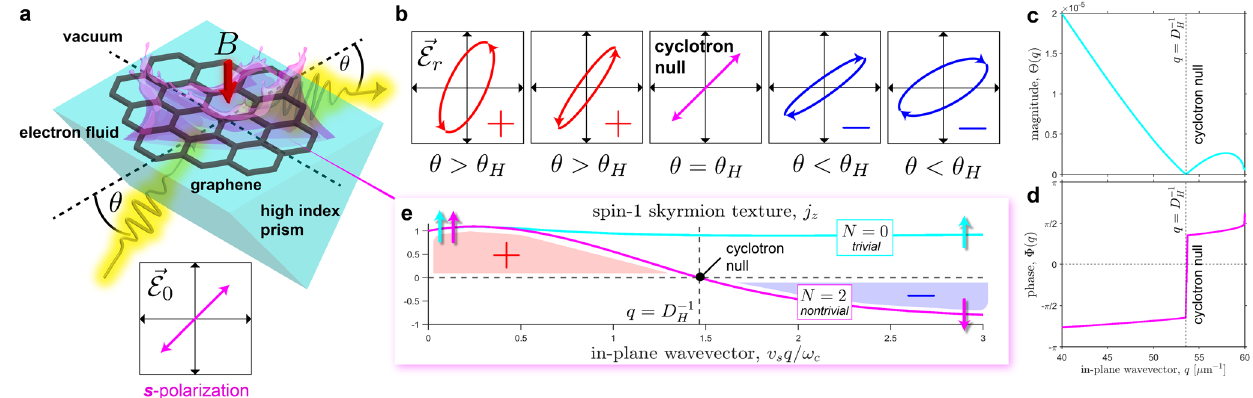
Fig. 3 Experimental e-MOKE setup of topological viscous Hall fl uid. a Overview of e-MOKE spectroscopy for direct measurement of the optical N -invariant through B - fi eld repulsion. b Evolution of the re fl ected polarization ellipse E The frequency of incident light is ω /2 π = 286 THz. The ellipticity gradually changes for various incident angles ( θ ) but abruptly switches handedness due to skyrmionic vorticity. This cyclotron null coincides with an incident angle tan θ H ¼ c , d Magnitude Θ and phase Φ of the Kerr rotation plotted against the in-plane momentum q . e The optical N -invariant encodes the angular momentum texture of spin-1 Néel-type skyrmions and is identi fi ed with the skyrmion winding number Δ j z = N . This is an experimentally measurable signature of the N -invariant. In the nontrivial phase N = 2, the spin fl ips direction which is indicated by the arrows at the high-symmetry points q = 0 and q = ∞ room temperature. Theoretical plots of the Kerr rotation are displayed in Fig. 3c, d.